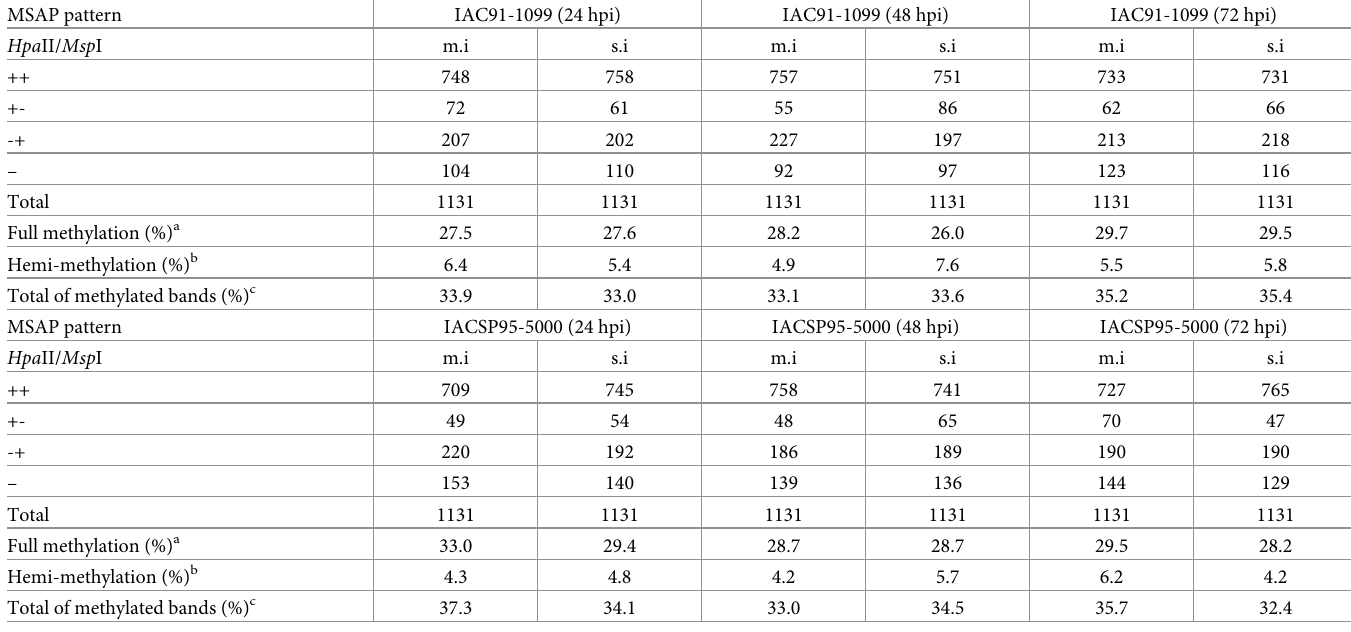
Table 1. MSAP pattern frequency for cultivars IAC91-1099 and IACSP95-5000 under mock inoculation (m.i) and mechanical inoculation with SCMV (s.i) treat- ments at 24, 48, and 72 hpi. (+) and ( − ) represent presence and absence of bands, respectively. MSAP